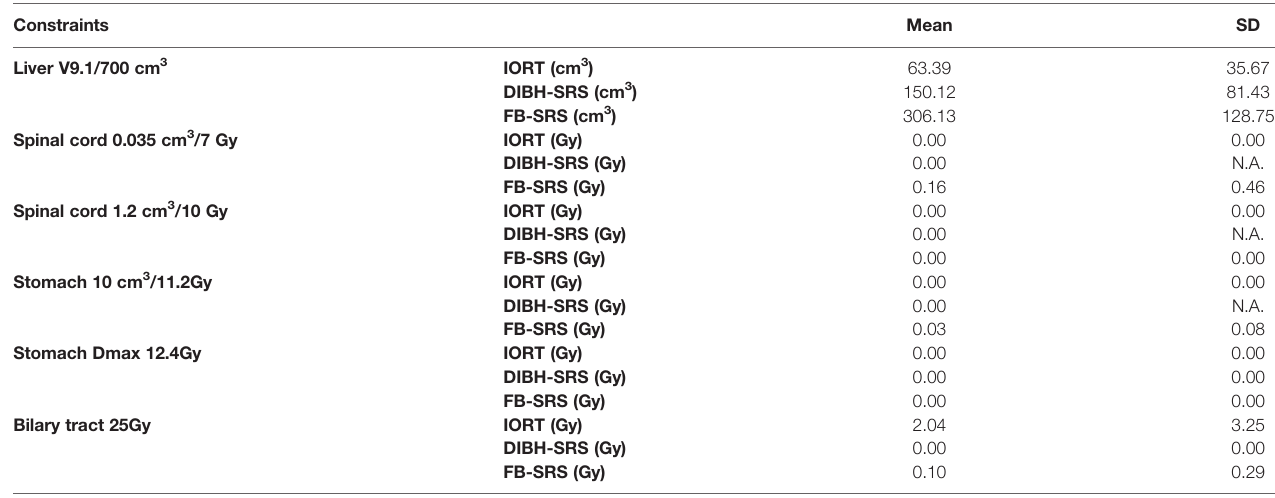
TABLE 3 | Organs at risk exposure.